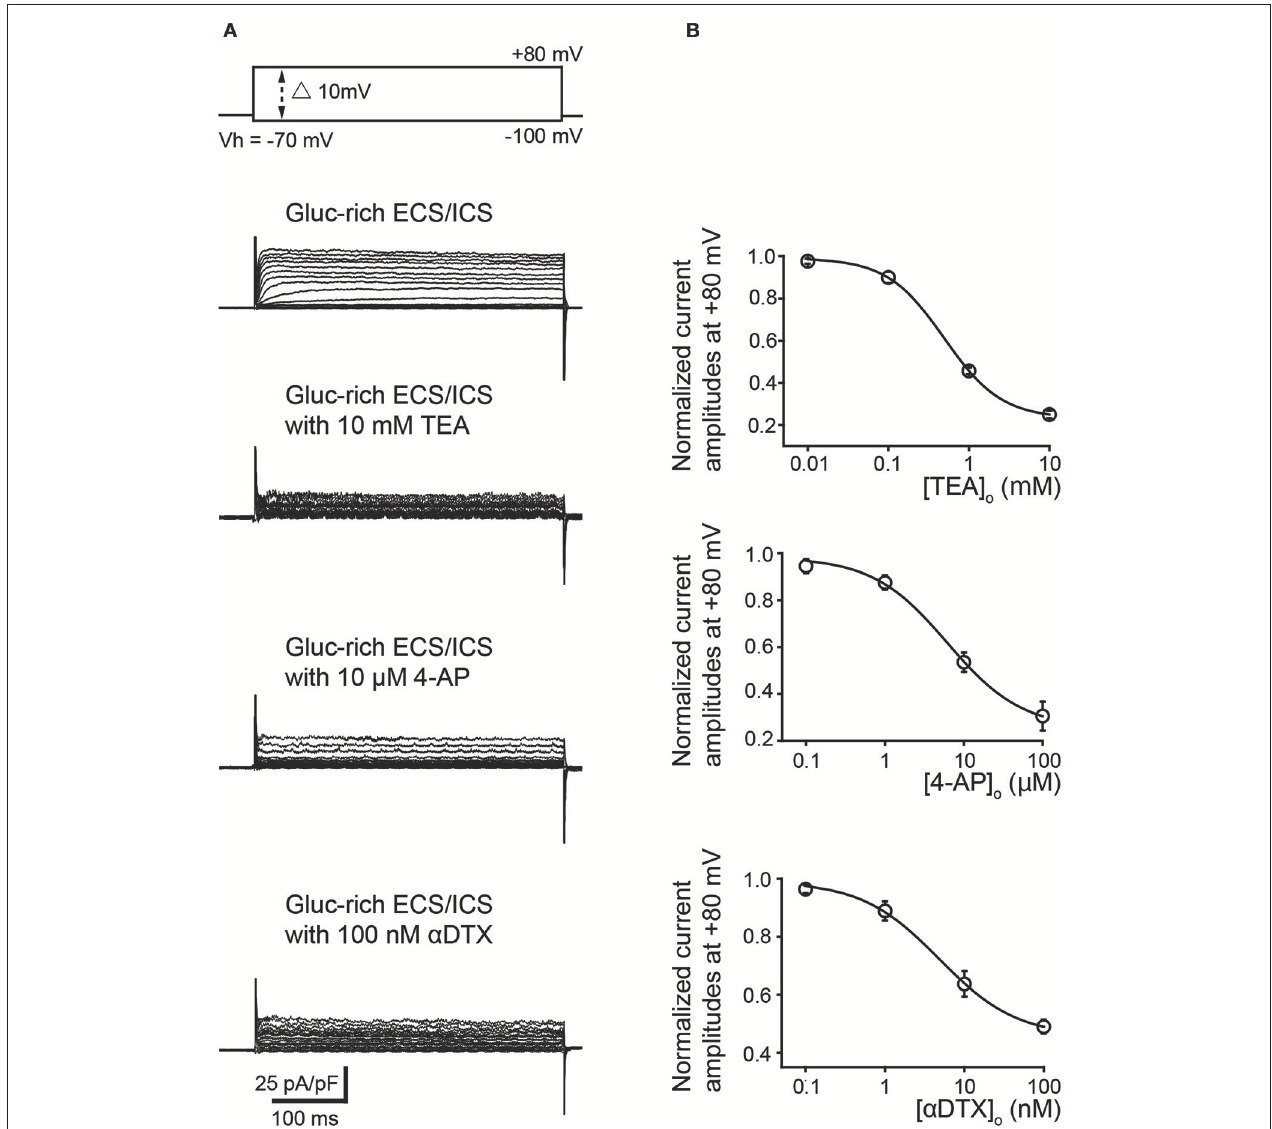
FIGURE 3 | Pharmacological properties of outward currents in odontoblasts. (A) Representative current traces recorded under gluc-rich ECS and ICS conditions without (second upper traces) and with 10mM TEA (third upper traces), 10 µ M 4-AP (forth upper traces), and 100nM α DTX (bottom traces) are shown. Currents were evoked by 400ms voltage-steps from − 100 to + 80mV in 10mV increments from a Vh of − 70mV (upper traces). (B) Dose-response relationships between current amplitudes normalized to those without antagonist and those with various concentration of extracellular antagonist: TEA (upper), 4-AP (middle), and α DTX (lower). Each data point was best fitted using Equation 2 , and each IC 50 value was evaluated. Each point indicates the mean values ± SD from each 6